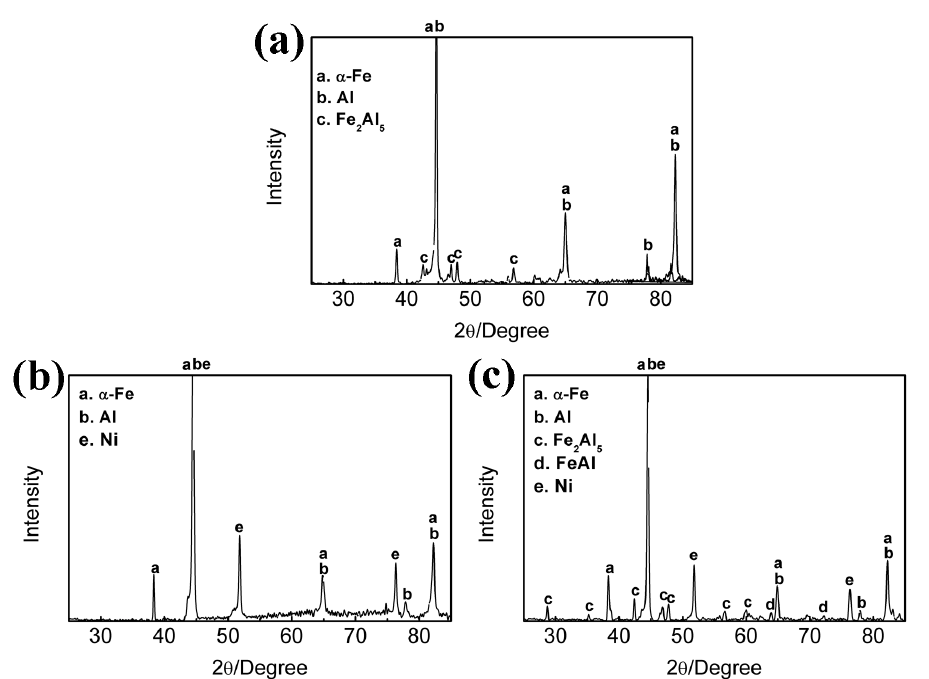
Figure 6. XRD patterns at the interface for ( a – c ) processes I, III and IV.